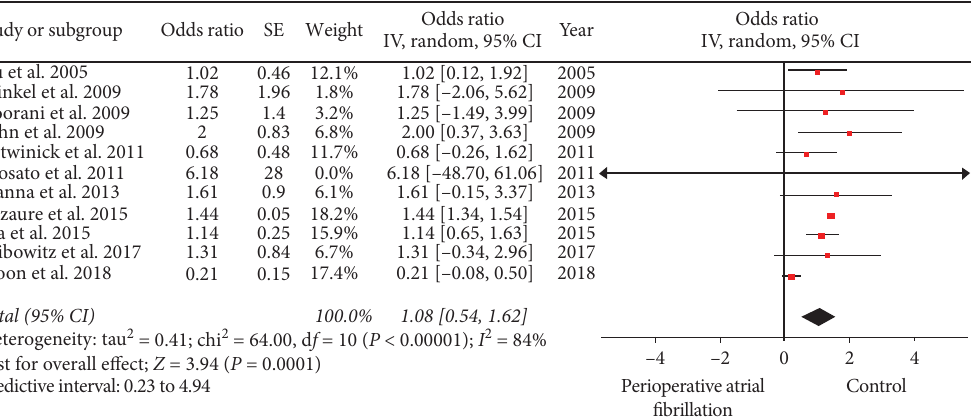
Figure 3: Forest plot evaluating male gender as a risk factor for perioperative atrial fibrillation in patients undergoing noncardiothoracic surgery. The odds ratio of each included study is plotted. A pooled estimate of overall odds ratio (diamonds) and 95% confidence intervals (width of diamonds) summarizes the effect size using the random effects model. CI � confidence interval; M–H � Mantel–Haenszel; OR � odds ratio; I 2 : heterogeneity; P < 0 . 05 is (OR: 0.92; 95% CI: 0.45 to 1.40; I 2 : 49%; P � 0 . 0001). Egger’s